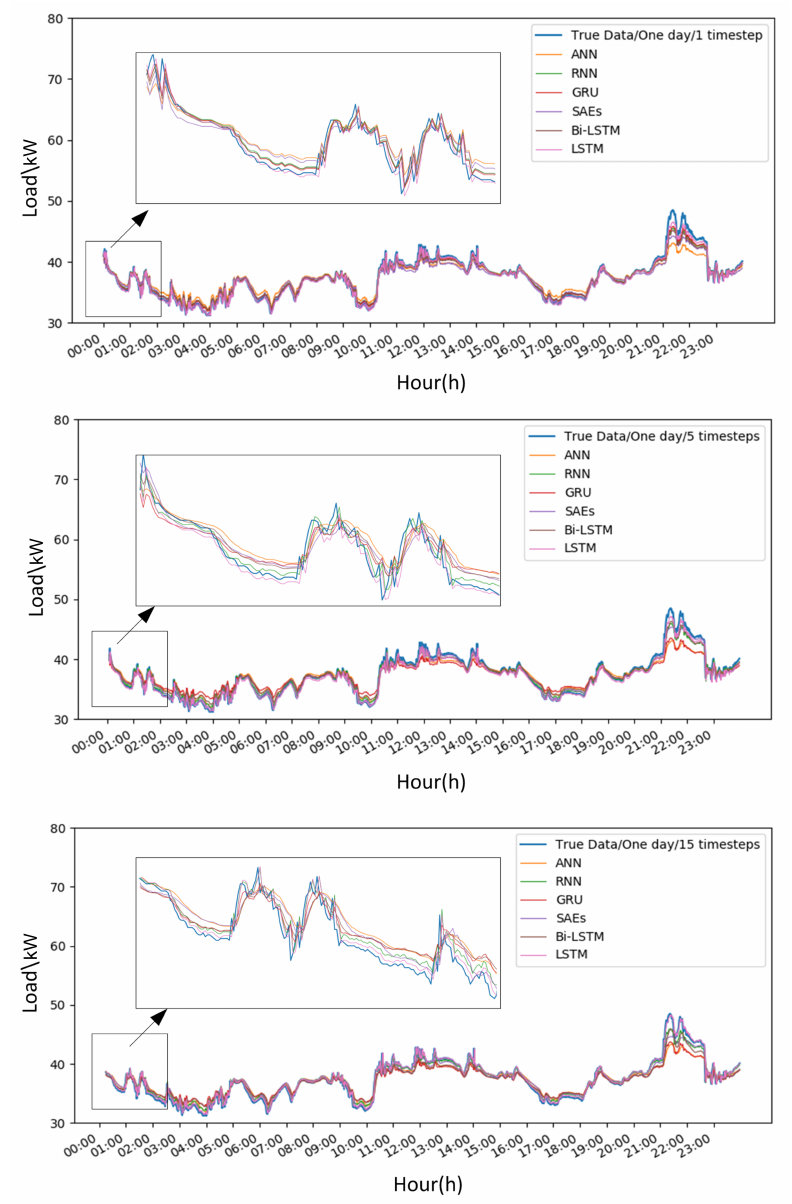
Figure 13. Load forecasting curve effect comparison graph of the PEV